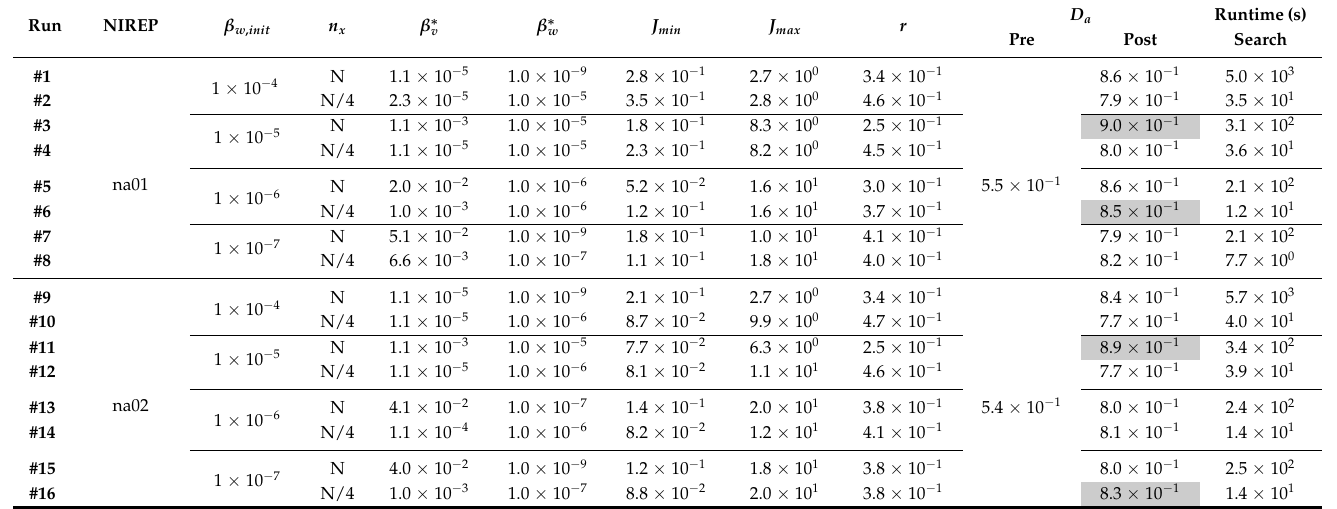
Table A1. Experiment 1b: effect of β w , init on registration performance for real brain images : Com- parison of registration accuracy using Dice and relative residual r for different values of β w , init at different resolutions for registration of MRI250 brain image to na01 and na02 from NIREP dataset. We fix β w , min = 1 × 10 − 9 . We consider n x = { N , N /4 } where N = 640 × 880 × 880. We fix the tolerance for the relative gradient to 5 × 10 − 2 . We use linear interpolation. The Jacobian bounds for parameter search are [ 0.05,20 ] . We increase the number of time steps n t proportionately with increase in resolution. We report β ∗ v and β ∗ w , the regularization parameters from the parameter search scheme, J min and J max , the minimum and maximum Jacobian determinant the relative residual r , average Dice D a pre and post the registration and the wall clock time for the parameter search for the registration. We highlight the best Dice scores for each resolution and for each NIREP